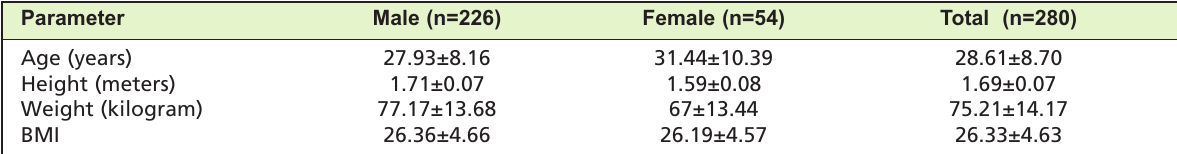
Demographic profile of cohort Table I: